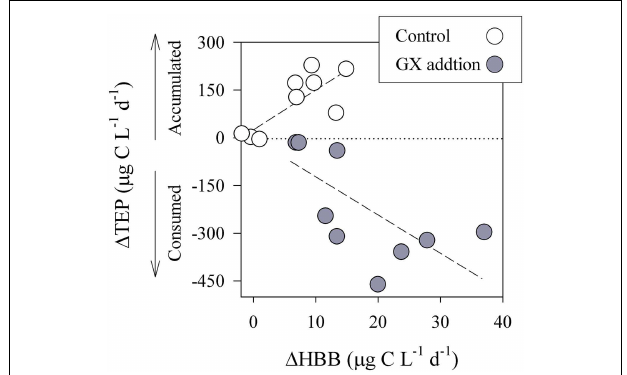
FIGURE 6 | Relationship between changes in TEP concentrations ( 1 TEP = T 2 -T 0 ) and differences in heterotrophic bacterial biomass ( 1 HBB = T 2 -T 0 ). Data was collected from both the control (white circles) and GX enriched (gray circles) bottle incubations. Linear regression is shown